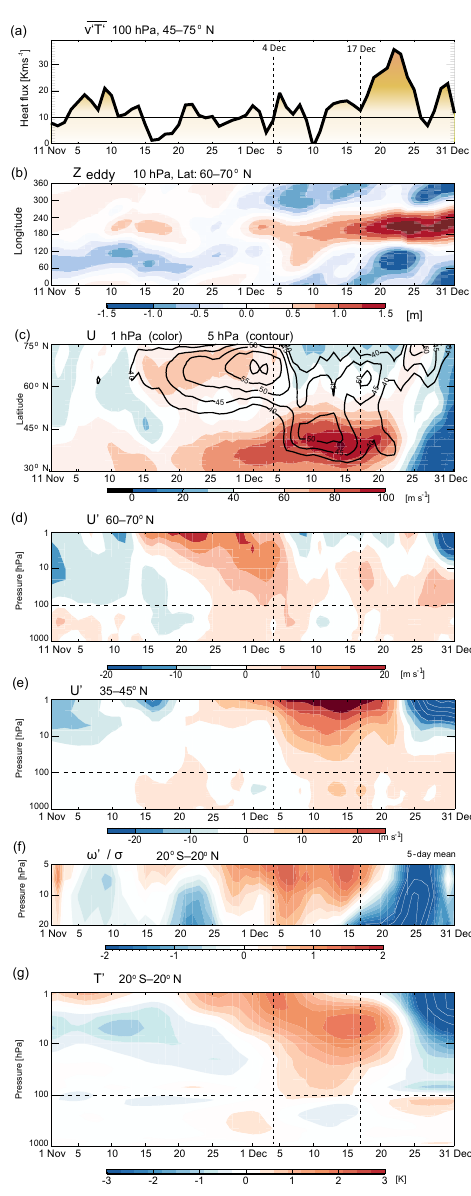
Figure 3. (a) Eddy heat flux at 100hPa averaged over 45–75 ◦ N. (b) Zonally asymmetric component of the geopotential height aver- aged over 60–70 ◦ N at 10hPa. (c) Latitude–time section of zonal- mean zonal wind at 1hPa (colour shading) and 5hPa (contours). (d) Height–time section of anomalous zonal-mean zonal winds av- eraged over 60–70 ◦ N. (e) Same as (d) but for zonal wind aver- aged over 35–45 ◦ N. (f) Anomalous vertical pressure velocity av- eraged over 20 ◦ S–20 ◦ N. For (f) , a 5-day running mean was ap- plied. (g) Same as (f) but for temperature. Analysis period is from 1 November to 31 December 2011, and the time mean field dur- ing the period is further subtracted from anomalies in (f) and (g) . Vertical lines indicate 4 and 17 December with periods of tropical warming in the lower